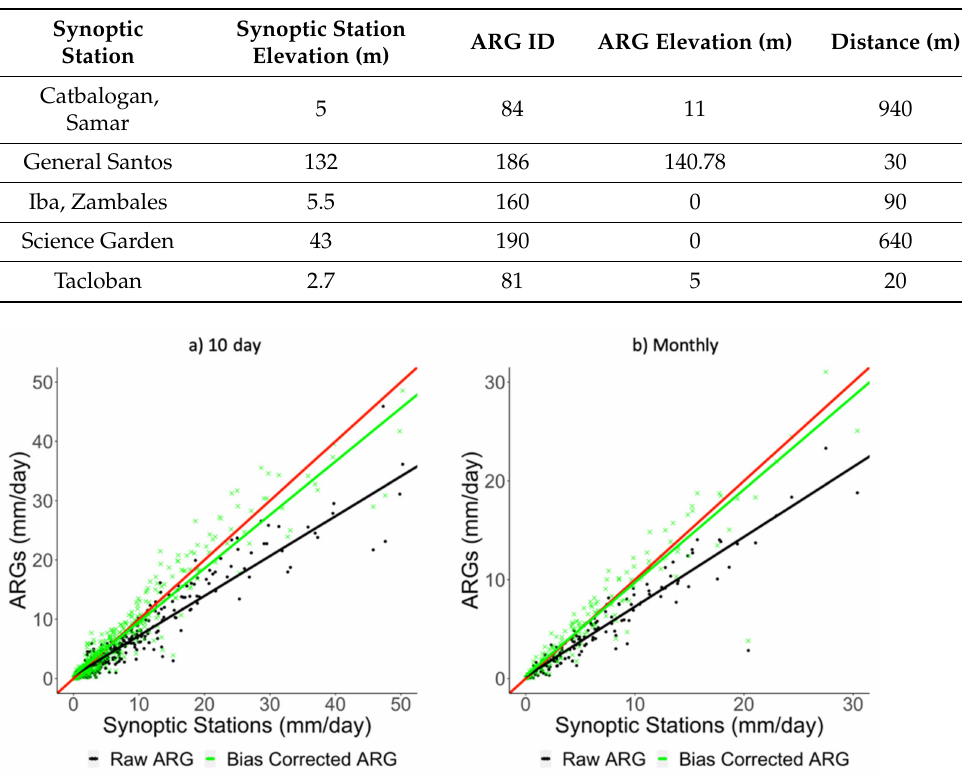
Table 1. Elevation and distance information of synoptic and ARG pairs used for bias correction.